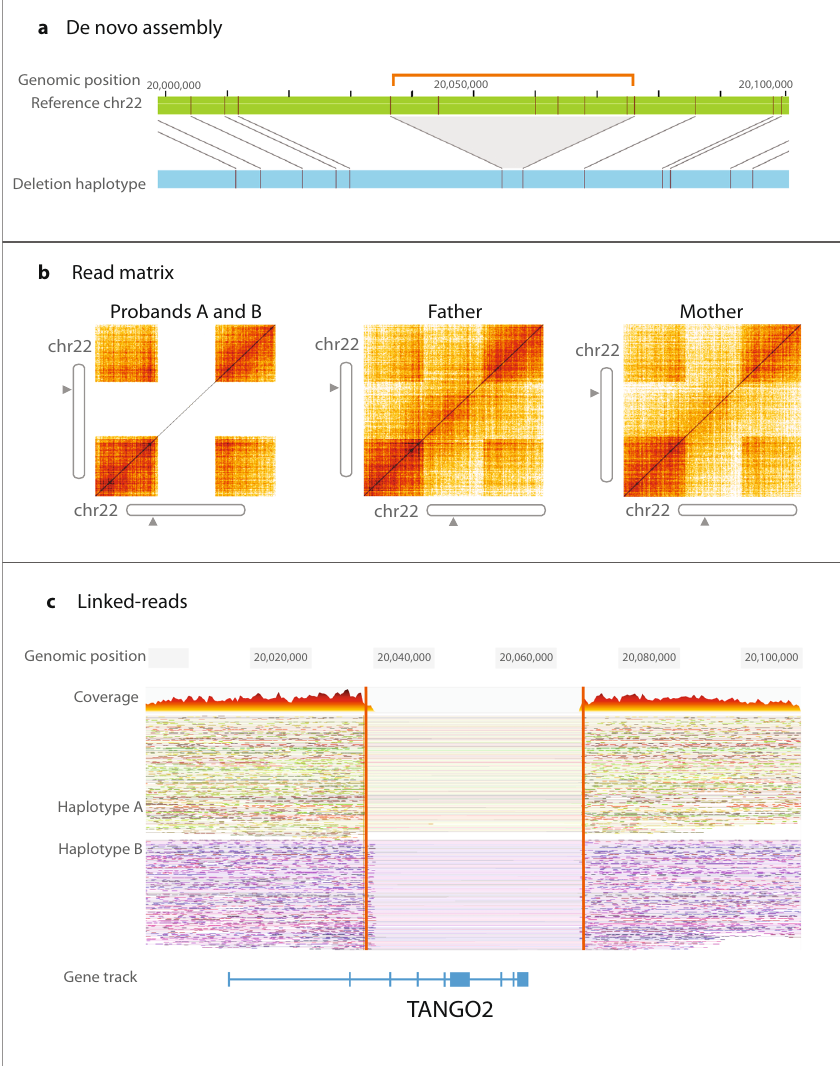
Fig. 3 Deletion disrupting TANGO2 (chr22: 20,039,637 – 20,075,714 and chr22: 20,041,469 — 20,075,432, genome version GRCh38). a De novo assembly (light blue) demonstrates missing sequence labels with respect to reference (green). The orange bracket and gray triangle show the deleted region. b Matrix view with absent signal from intervening region demonstrates proband with biallelic deletion. c Deletion is also seen by drop in coverage in both haplotypes in linked-read